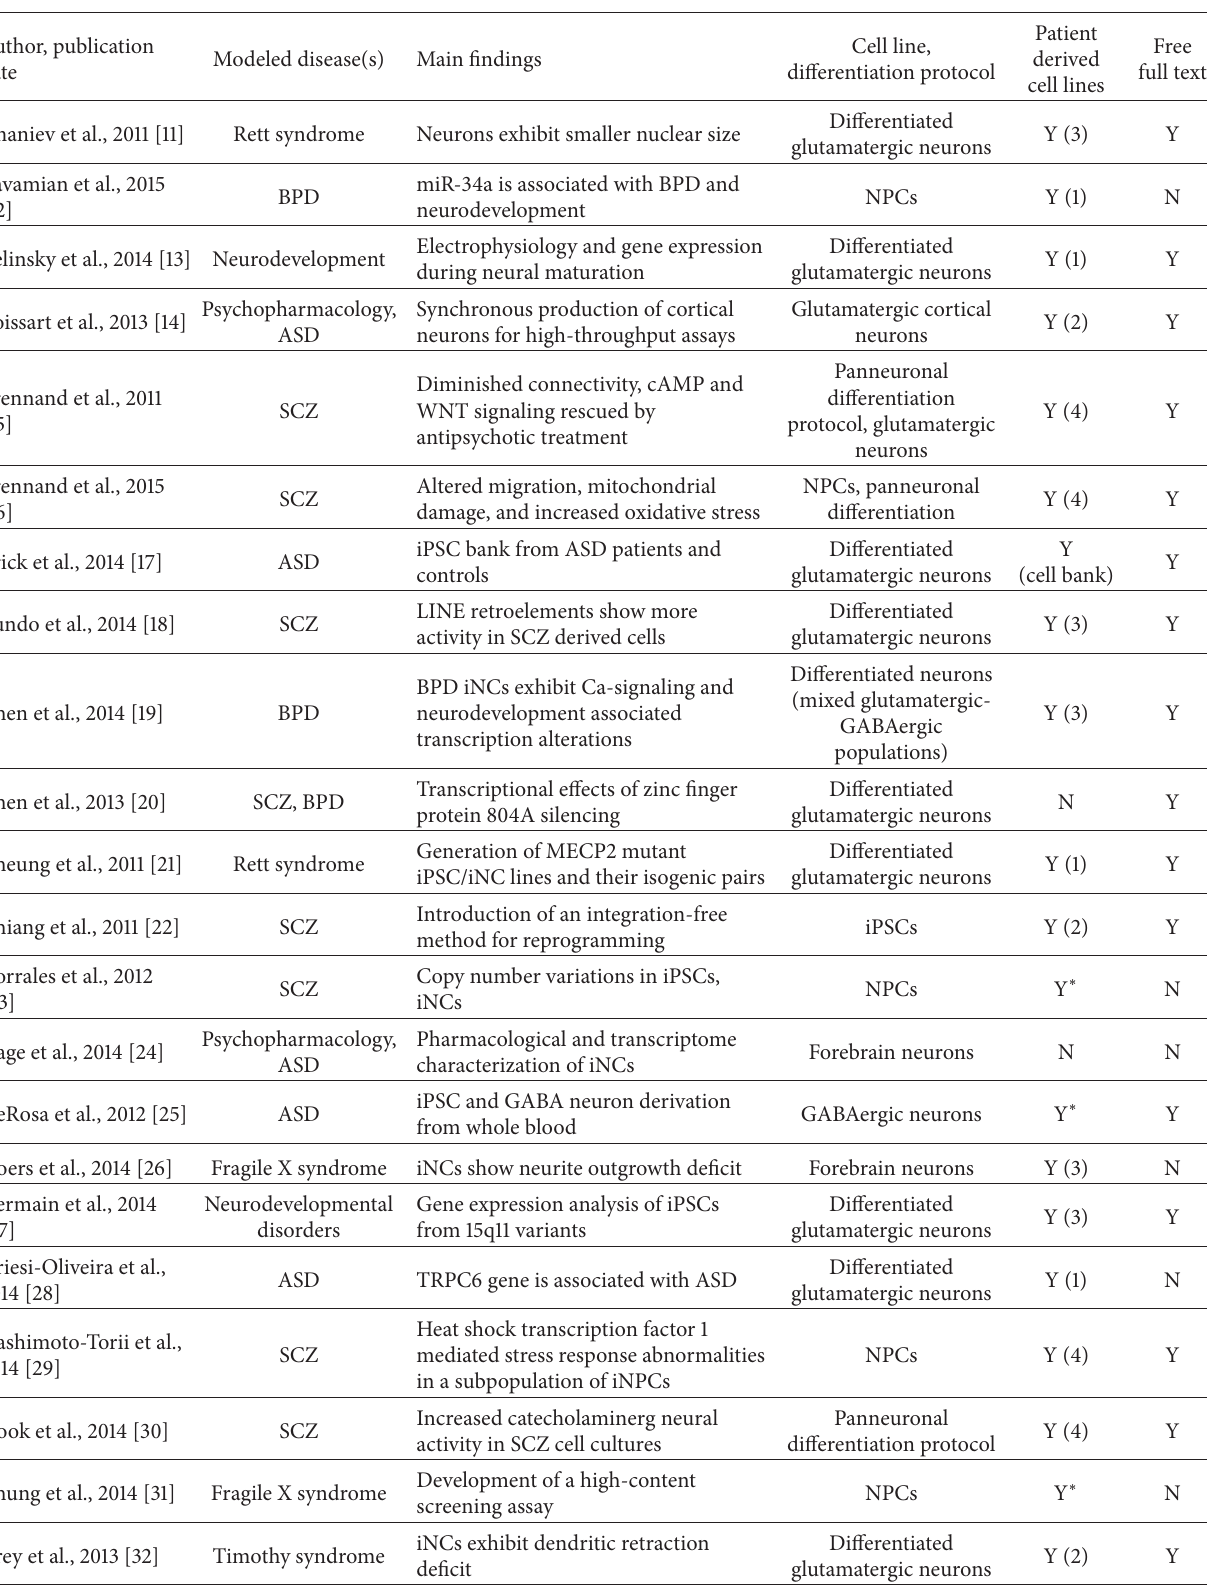
Table 2: (a) Research articles using induced pluripotent stem cells and/or induced neural cells in studying psychiatric disorders. (b) Review articles on induced pluripotent stem cells and/or induced neural cells in modeling psychiatric